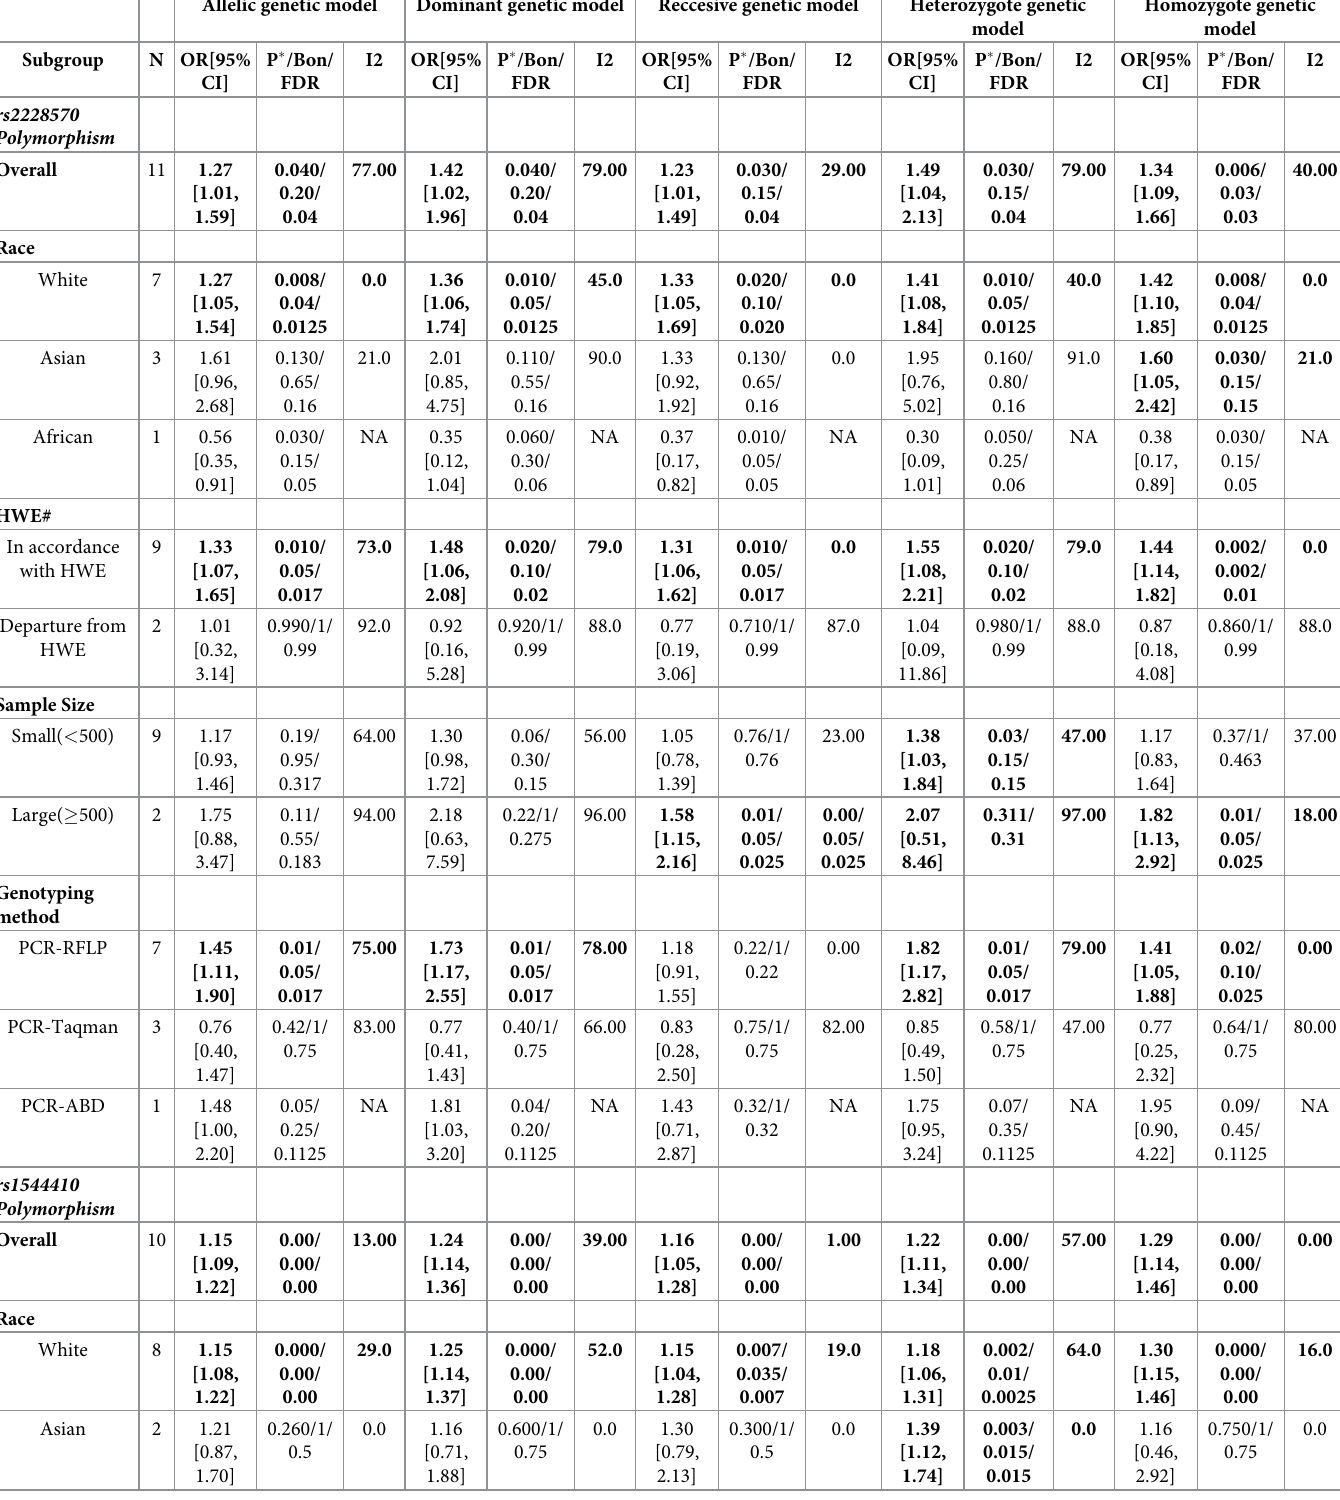
Table 2. Overall and subgroup analysis of the associations of the four VDR polymorphisms with coronary artery disease